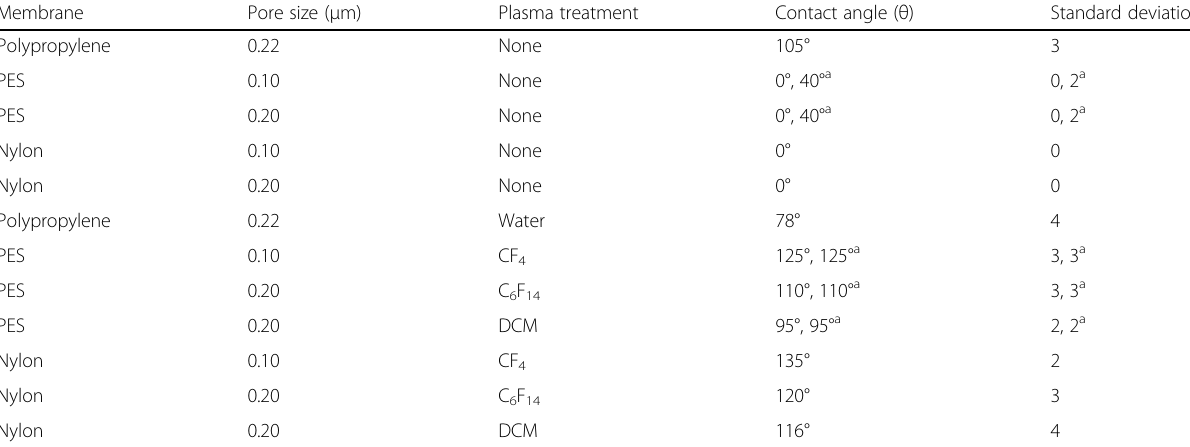
Table 1 Contact angle of unprocessed and plasma treated membranes ( n = 3) Membrane